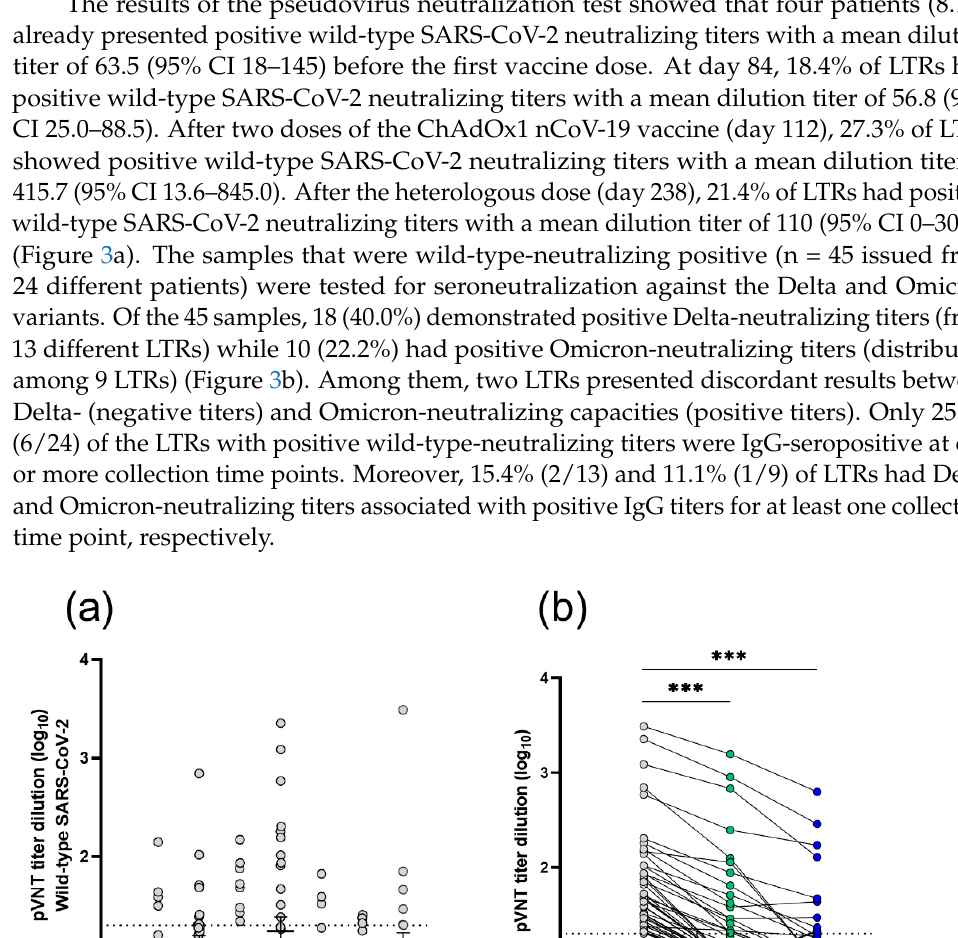
Table 3. Demographic and clinical characteristics of LTRs with stratification by antibody and neu- tralization responses after vaccination scheme completion. Seropositive LTRs with neutralization capacities assessed by sVNT were evaluated at day 238 (n = 9) as well as non-responders (n = 19). Seroneutralization against wild-type SARS-CoV-2 and the Delta and Omicron variants was rec- orded for LTRs with positive titers for least at one collection time point. LTRs, (n) Seropositive with neutralization ca- pacities (sVNT), (9) (%) Seronega- tive, (19) (%) p -value With WT neutralization ca- pacities, (24) (%)